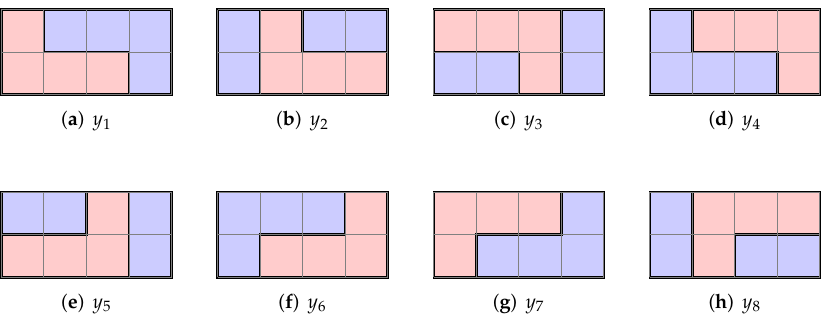
Figure 1. Possible placements of a tetromino in R and the associated